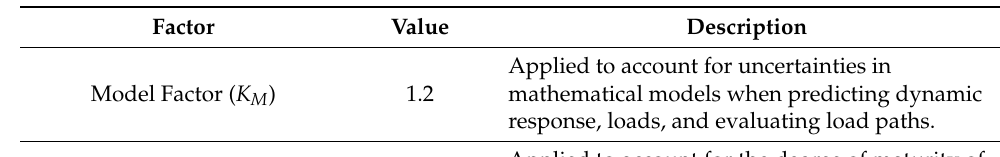
Table 3. Factors related to dynamic launch